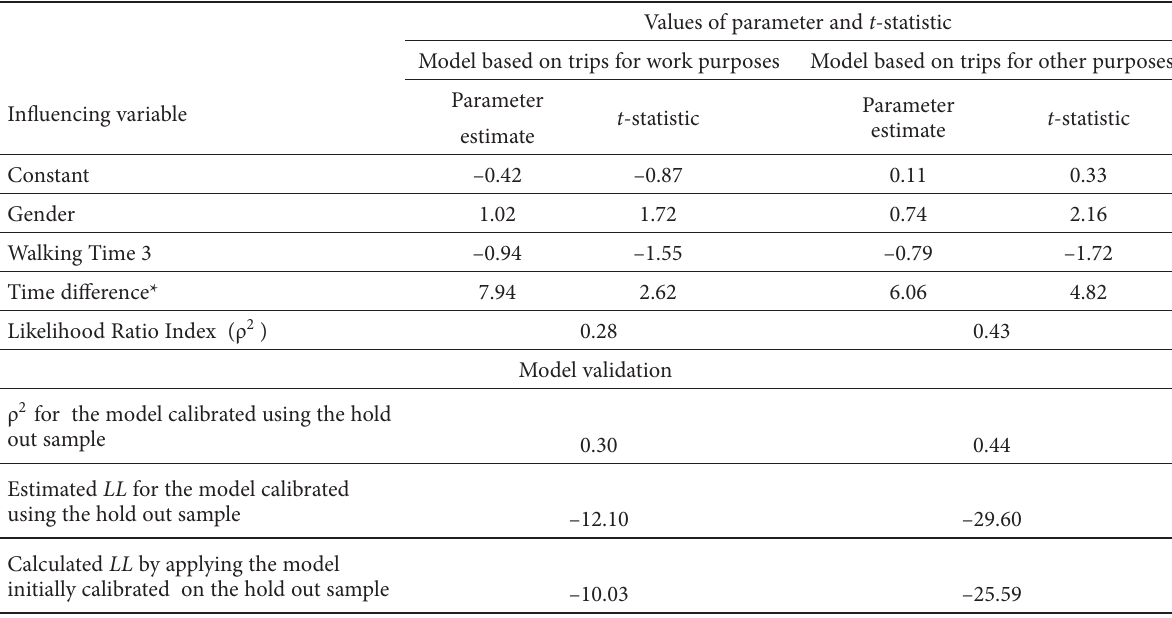
Table 4. Th e results of calibration and validation of the models based on trip purposes